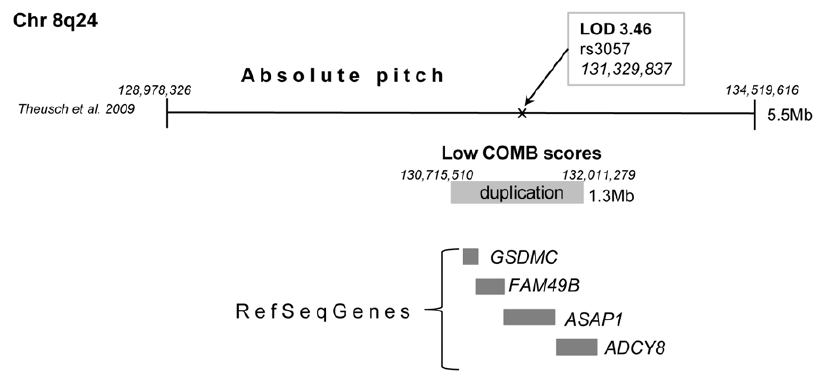
Figure 2. 1.3 Mb duplication in the region previously linked with absolute pitch.